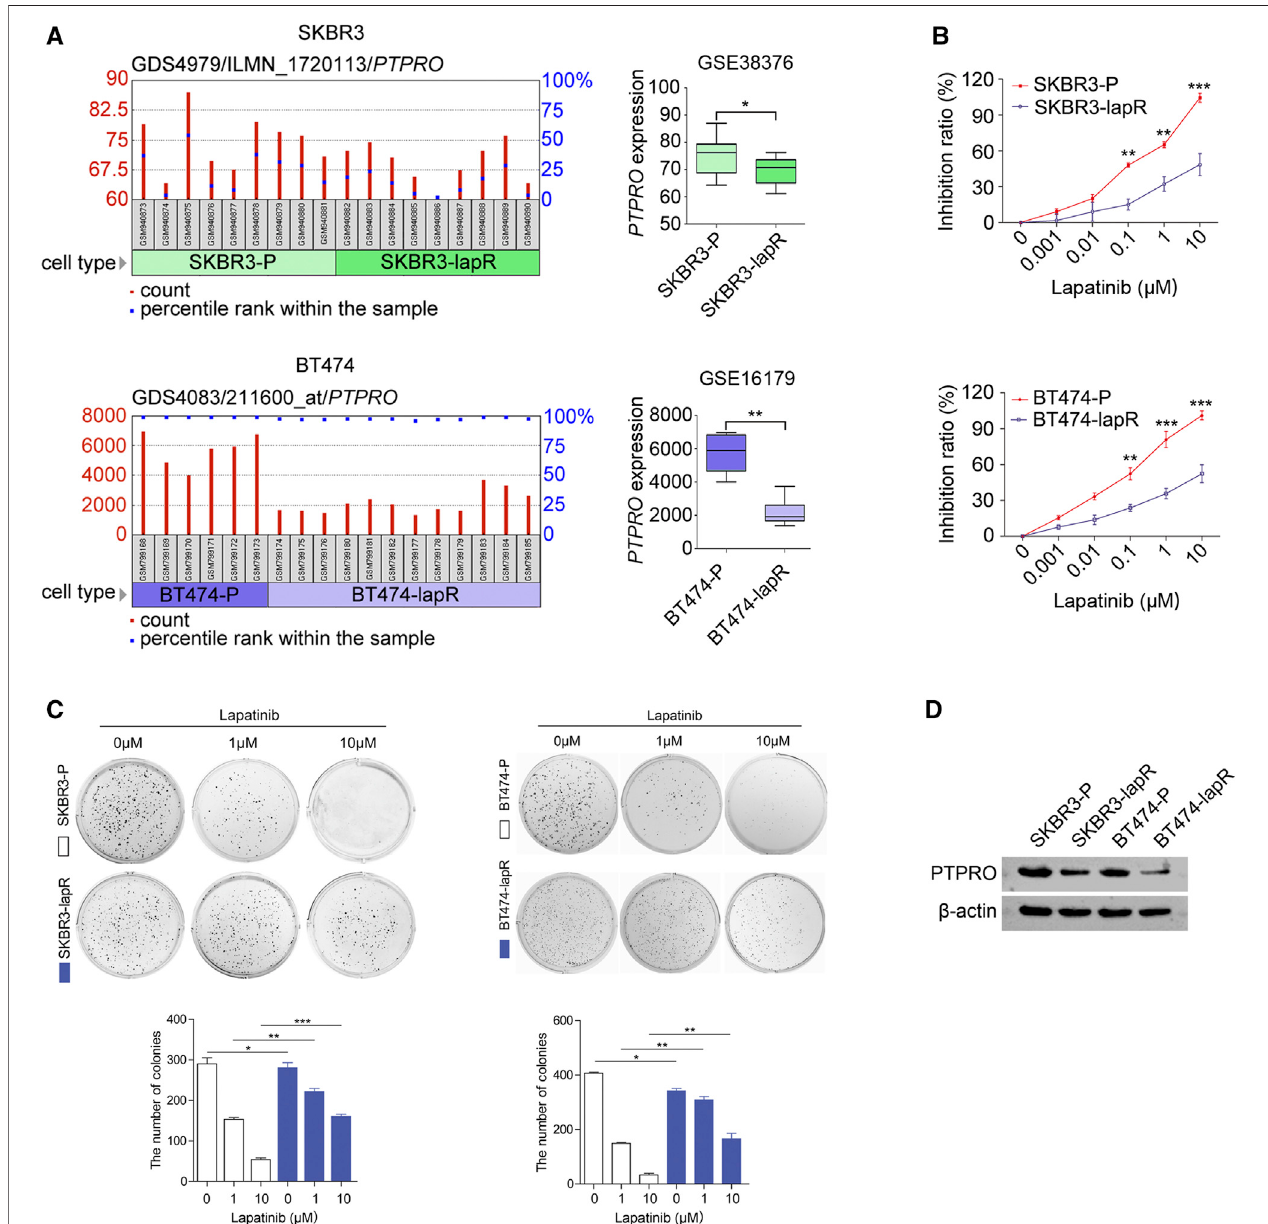
FIGURE 3 | PTPRO is downregulated in lapatinib-resistant ERBB2-positive breast cancer cells. (A) The mRNA level of PTPRO in the lapatinib resistant ERBB2- positive breast cancer cells, SKBR3-lapR and BT474-lapR, compared with their parental cells, SKBR3-P and BT474-P. The dataset GSE38376 and GSE16179 were get from GEO (https://www.ncbi.nlm.nih.gov/geo/). (B) Inhibition ratio analysis of SKBR3-lapR and SKBR3-P (upper panel), BT474-lapR and BT474-P (bottom panel) wasevaluatedbyMTTassayaftertreatmentwithlapatinib. (C) ColonyformationabilitiesofSKBR3-lapRandSKBR3-P(leftpanel),BT474-lapRandBT474-P(right panel) were evaluated after treatment with lapatinib, and the number of colonies was counted (bottom panel). (D) The PTPRO protein expression derived from lapatinib resistant ERBB2-positive cells and their parental cells were assessed by western blot analysis. Data were shown as the means of three independent experiments or representative data. Error bars indicate SEM. * p < 0.05, ** p < 0.01, *** p < 0.001 by Student ’ s t-test or one-way ANOVA with post hoc intergroup comparisons, where appropriate.